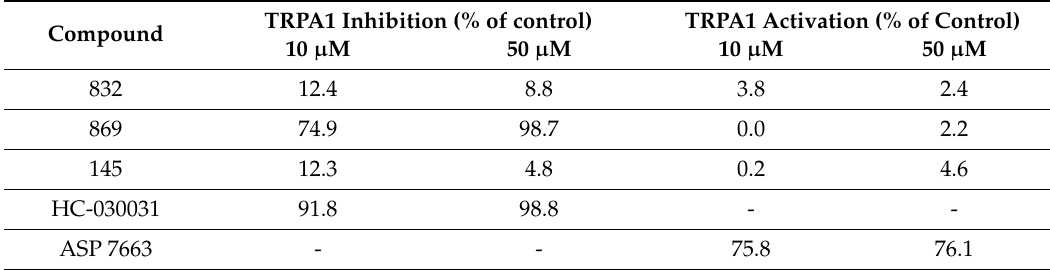
Table 2. Compounds 832, 869, and 145 as TRPA1